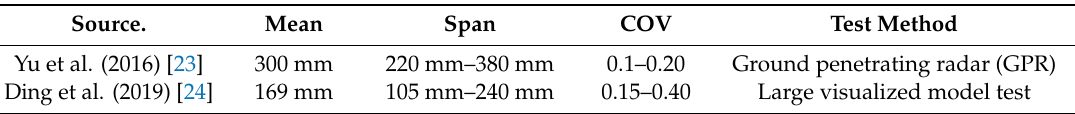
Figure 1. Schematic diagram of backfill-grouting-layer distribution. Table 1. Statistic parameters of grouting-layer thickness.